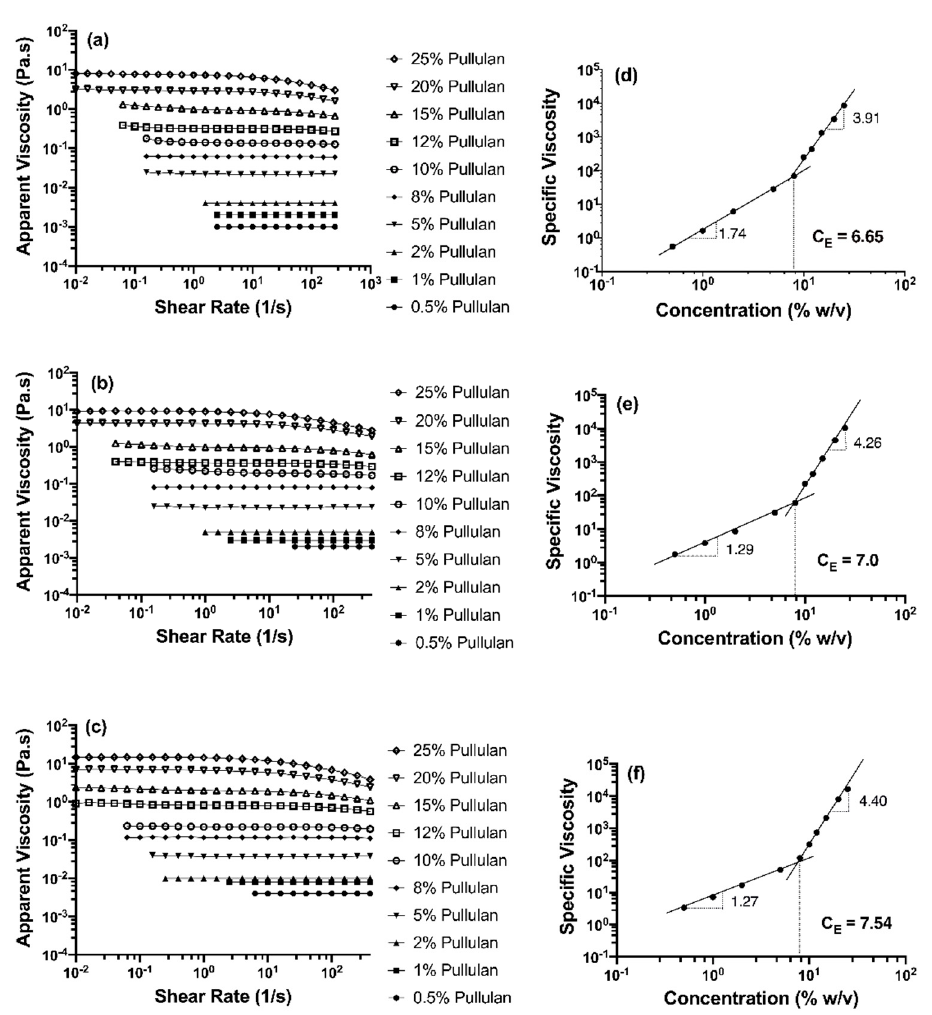
Figure 3. Flow curves of pullulan aqueous solutions at different concentrations (0.5–25% (w/v)) added with ( a ) 0, ( b ) 10 and ( c ) 30% (w/v) HP- β -CD. Plots of specific viscosity versus pullulan concentration for blends with ( d ) 0, ( e ) 10 and ( f ) 30% (w/v) HP- β -CD. The slopes of fitted lines (scaling exponents) in the semi-dilute entangled and semi-dilute unentangled regions, as well as the entanglement concentrations, C E (indicated with a vertical line), are illustrated.